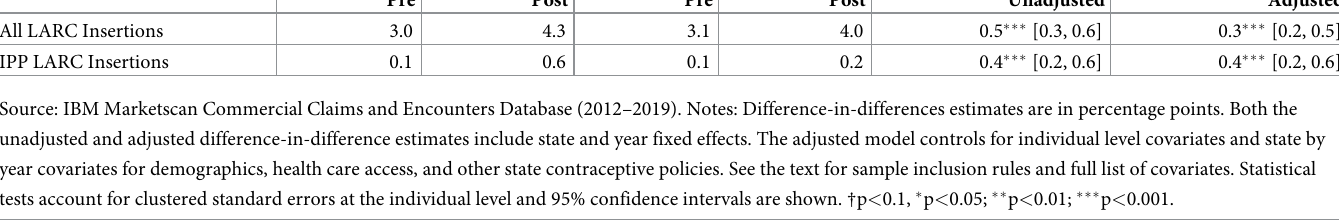
The subgroup patterns are mirrored in the patterns for insertion of IPP LARC. Younger enrollees age 15–29 account for the entirety of the effect and were associated with a 0.9 per- centage point (95% CI 0.5, 1.2; P < 0.001) increase in the probability of having an IPP LARC insertion after the program, compared to a statistically insignificant 0.04 percentage point increase (95% CI -0.2, 0.3; P = 0.73) for enrollees age 30–44. We cannot estimate separate effects on IPP LARC for enrollees age 15–17 due to the small number of births in our sample among this age group.